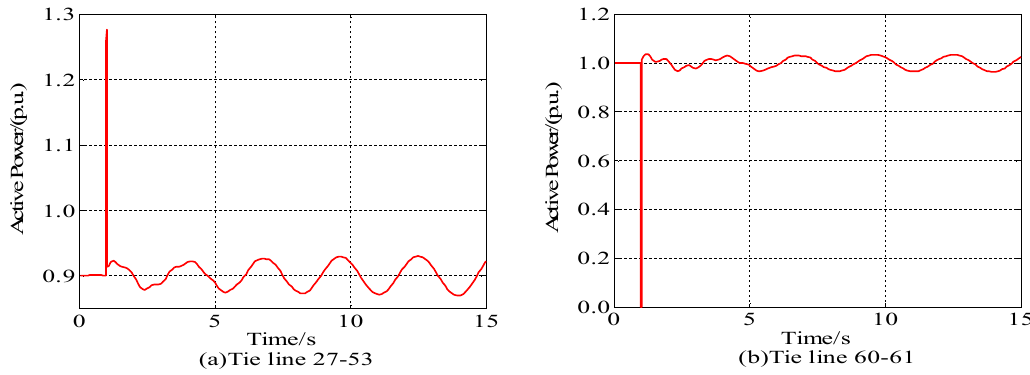
Figure 7. Power curve of tie lines for 27–53 and 60–61 under 50.17% wind power penetration. ( a ) the active power curves of the interarea tie lines 27–53; ( b ) the active power curves of the interarea tie lines 60–61.